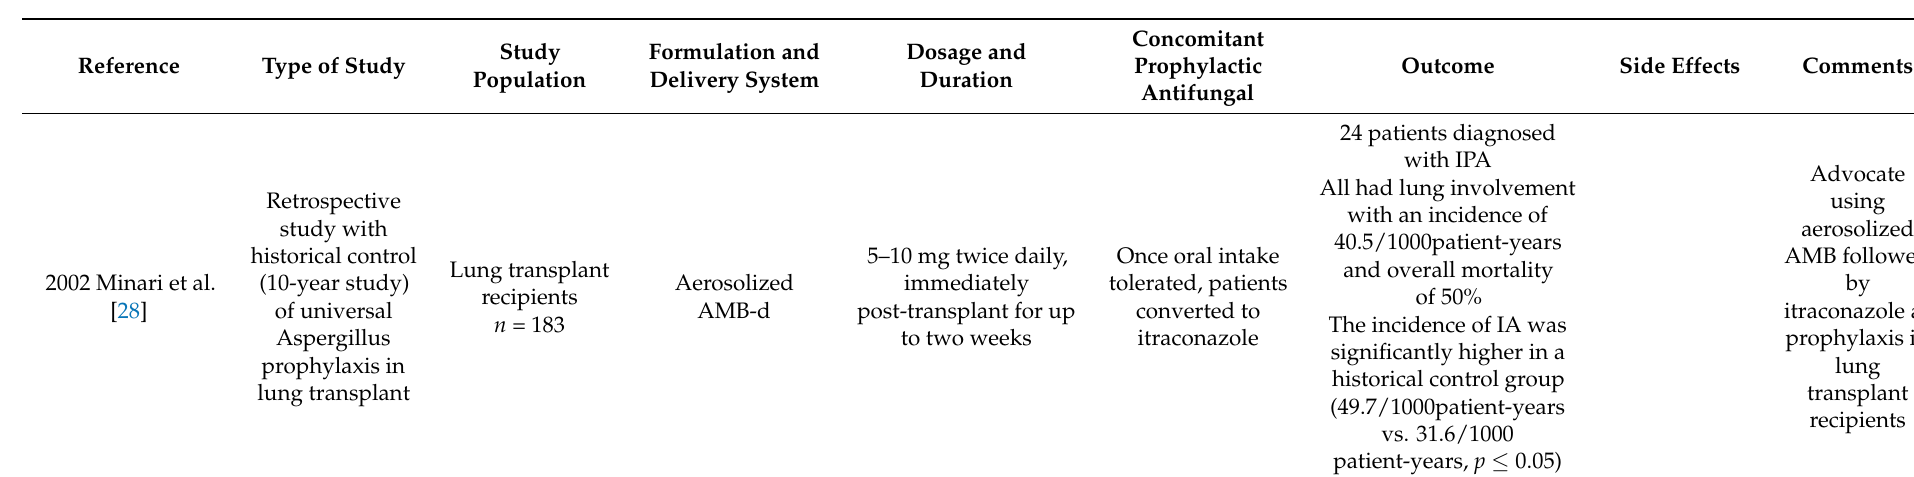
Table 2. Inhaled AMB as prophylaxis in lung transplant